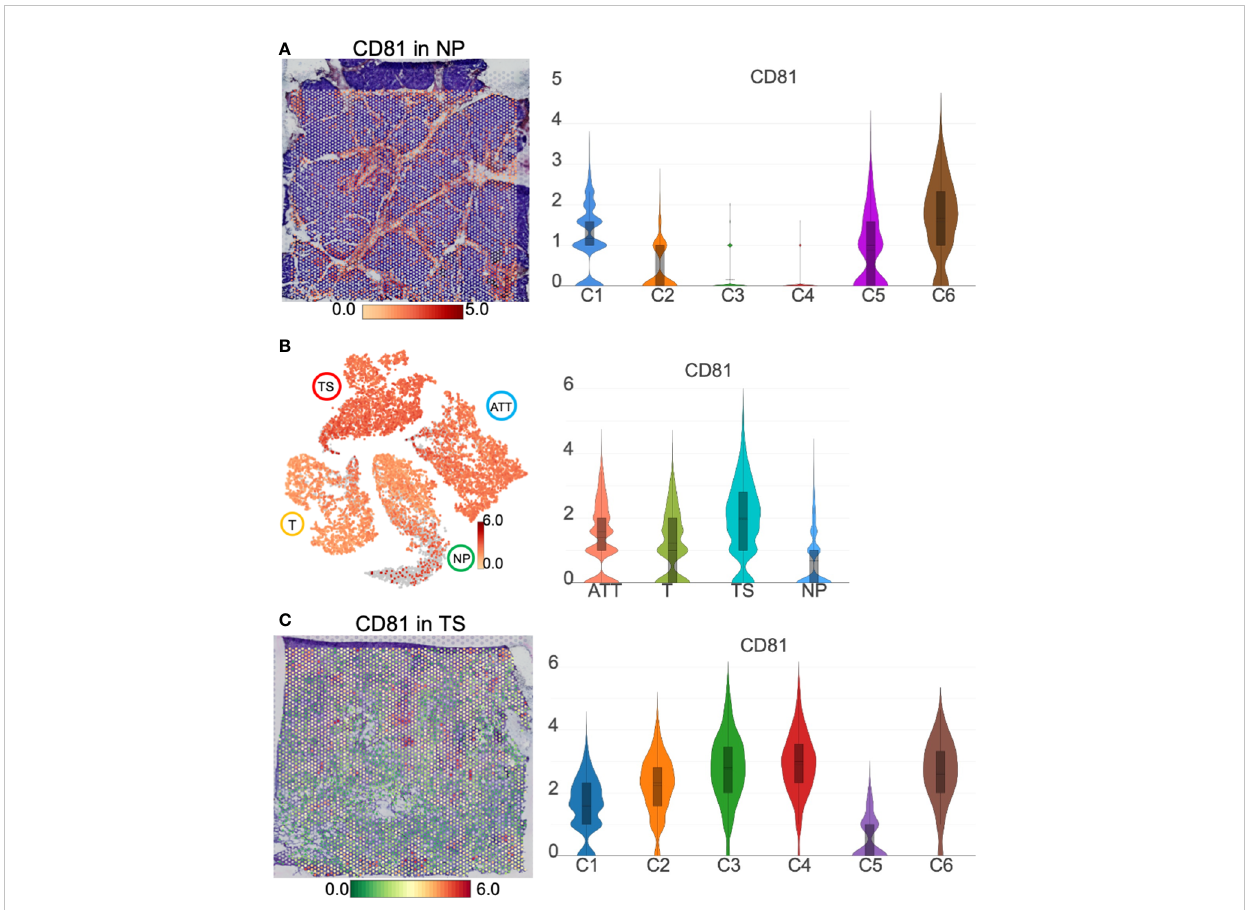
FIGURE 9 CD81 location and distribution in pancreatic tissues. (A) The distribution and level of CD81 in normal pancreas (NP). (B) The distribution and level of CD81 across the NP, adjacent tumor tissue (ATT), tumor (T), and tumor stroma (TS). (C) The distribution and level of CD81 in TS. The bar plots and the vertical coordinate of the violin plots indicates the log 2 FC of the gene expression value of each cluster versus the average gene